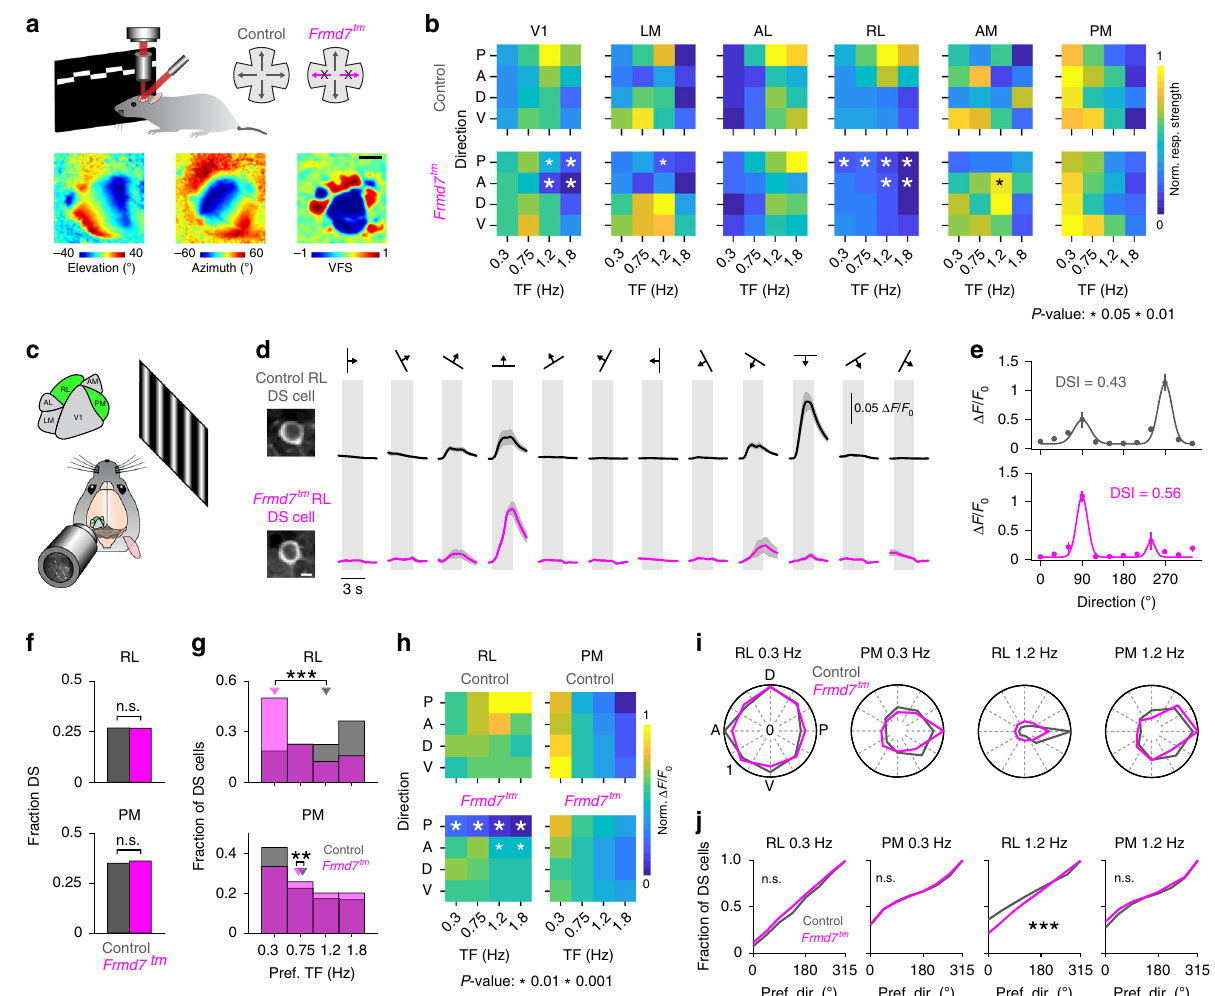
Fig. 1 Posterior motion preference of RL neurons at higher TFs depends on retinal horizontal direction selectivity. a Upper: ISOI in control and Frmd7 tm mice. Lower: Example vertical and horizontal retinotopic maps and the computed visual- fi eld sign map. Scale bar, 1 mm. b Response strength as a function of motion direction (anterior [A], posterior [P], dorsal [D], and ventral [V]) and TF ( fi ve mice per genetic group). White and black asterisks: signi fi cantly decreased and increased responses, respectively, two-sided Mann – Whitney U -test. c Two-photon calcium imaging from L2/3 in areas RL and PM of control (1452 and 1098 DS cells, respectively; ten mice) and Frmd7 tm mice (1387 and 1217 DS cells, respectively; 11 mice). d Example control and Frmd7 tm RL and PM neurons expressing GCaMP6f (scale bar, 5 µ m) and trial-averaged fl uorescence ( Δ F / F 0 ) time courses for the same neurons. Shading indicates SEM. e Tuning curves for neurons shown in d . Error bars are SEM; solid line is Gaussian fi t. f Fraction of DS cells in RL and PM (two-sided χ 2 test with Yates correction). g Preferred TF for DS cells in RL (two-sided Mann – Whitney U- test) and PM (two-sided Mann – Whitney U -test). Triangles show medians. h Response amplitude as a function of motion direction and TF for RL and PM DS cells. White asterisks: signi fi cantly decreased response amplitude in Frmd7 tm mice, two-sided Mann – Whitney U- test. i Fractional distributions of preferred motion directions for RL and PM DS cells at 0.3 and 1.2 Hz; fractions are normalized to the largest fraction across genetic groups. j Distributions of preferred direction at 0.3 and 1.2 Hz in RL and PM (two-sided Kolmogorov – Smirnov test). ** P < 0.01, *** P < 0.001, n.s., not signi fi cant, in f , g , and j . Source data are provided as a Source Data fi